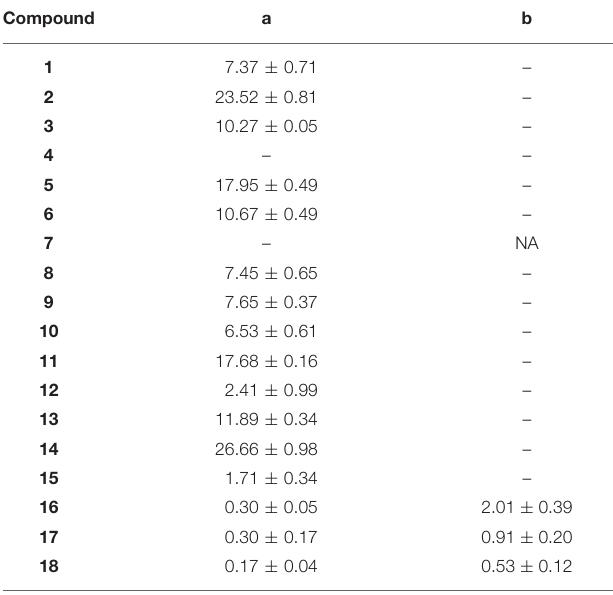
TABLE 3 | Summary of IC 50 values of itaconimide ( a ) and citraconimide ( b ) analogs against PAO1- lasB-gfp